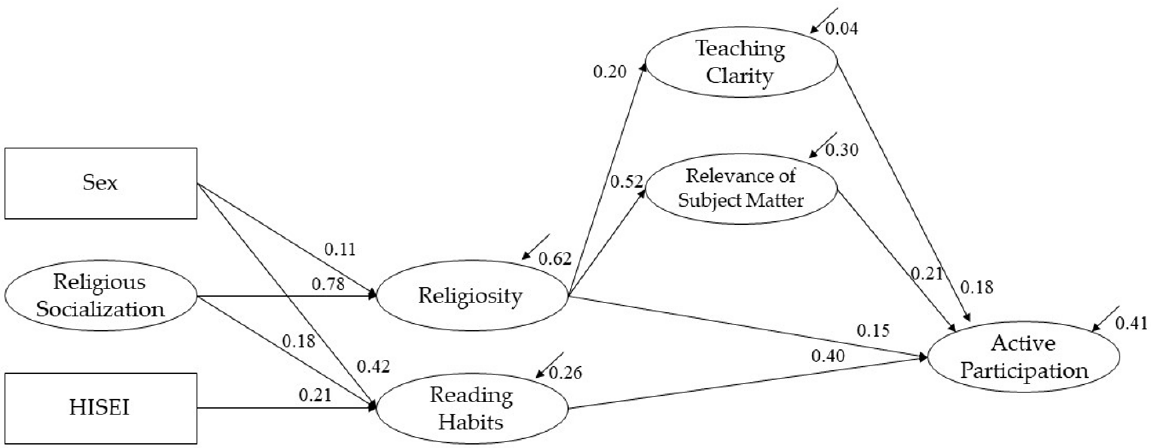
Figure 2. Structural equation model of unequal learning opportunities in RE. Note. Information about